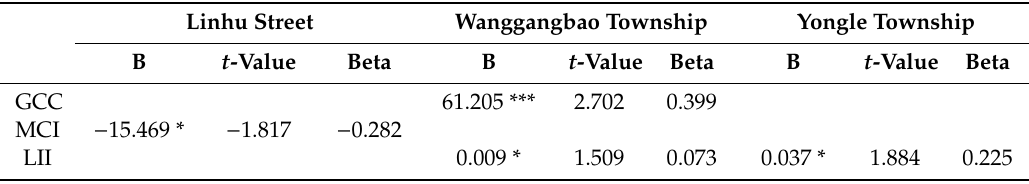
Table 4. Estimation